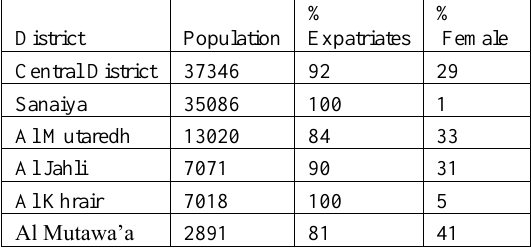
Table 3. Districts with a potential need for food